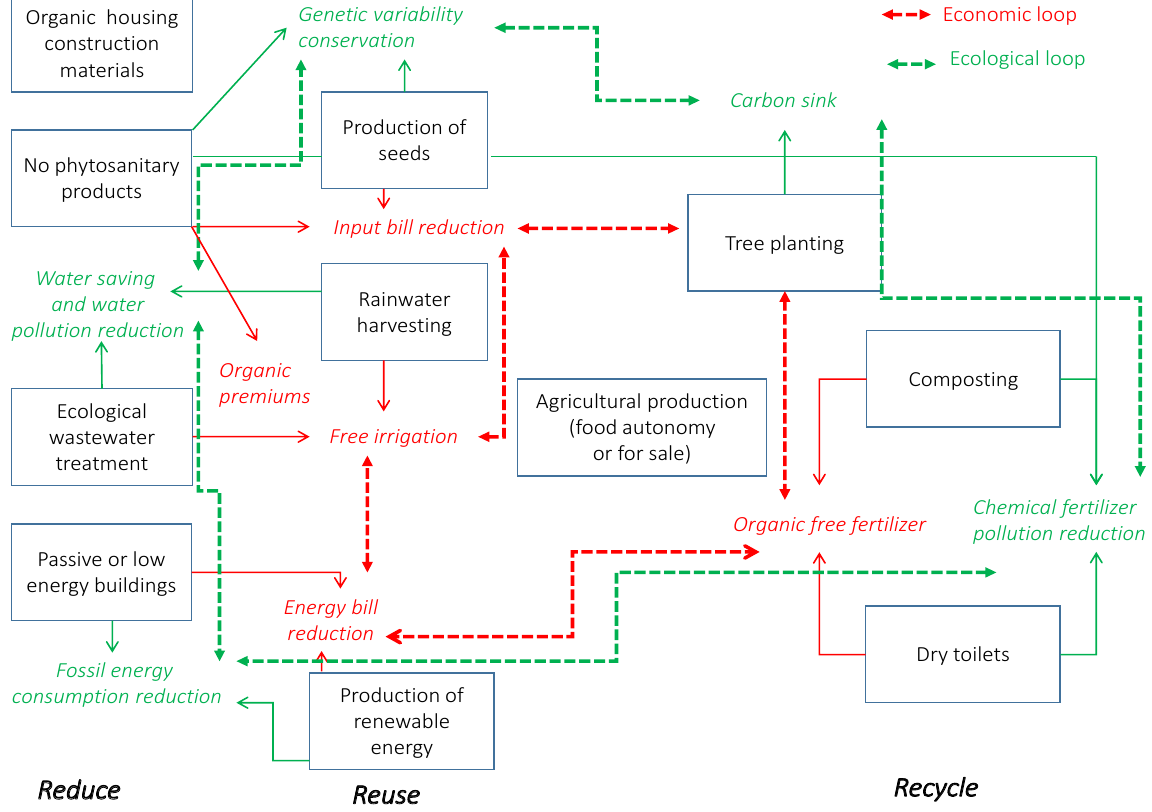
Figure 3. Economic and ecological